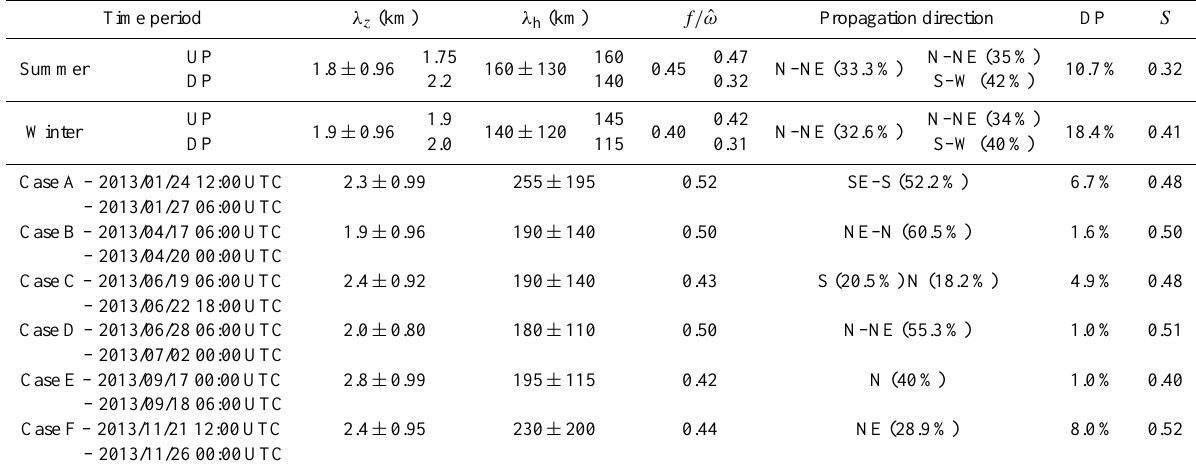
Table 1. Overview of mean properties of IGWs for different seasons and studied cases of strong wave activity. DP stands for Downward Propagating and UP for Upward